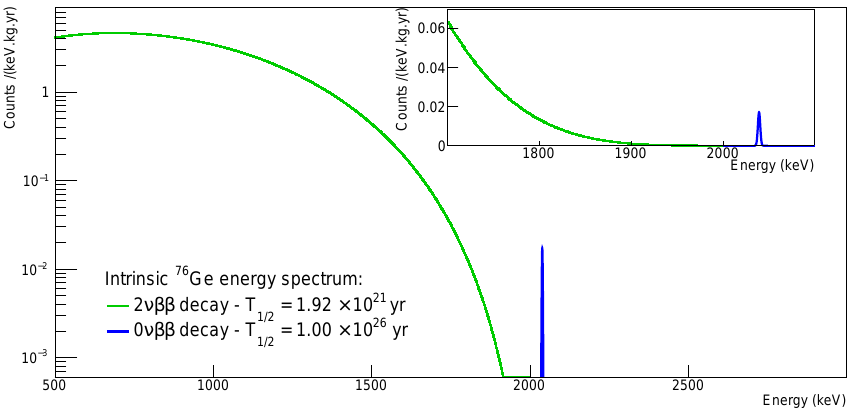
Figure 2. The expected 2 νββ (green) and 0 νββ (blue) for half-lifes of 1.93